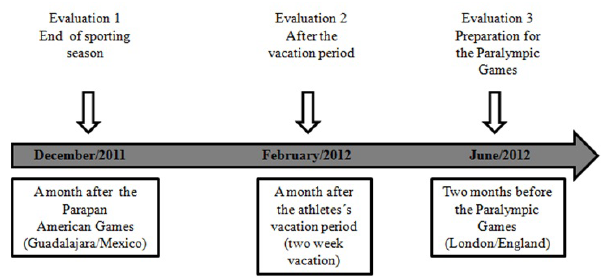
Participants Ten paralympic athletes (six men and four women), of the Brazilian track and field team, all with experience in international competitions participated in this study. The